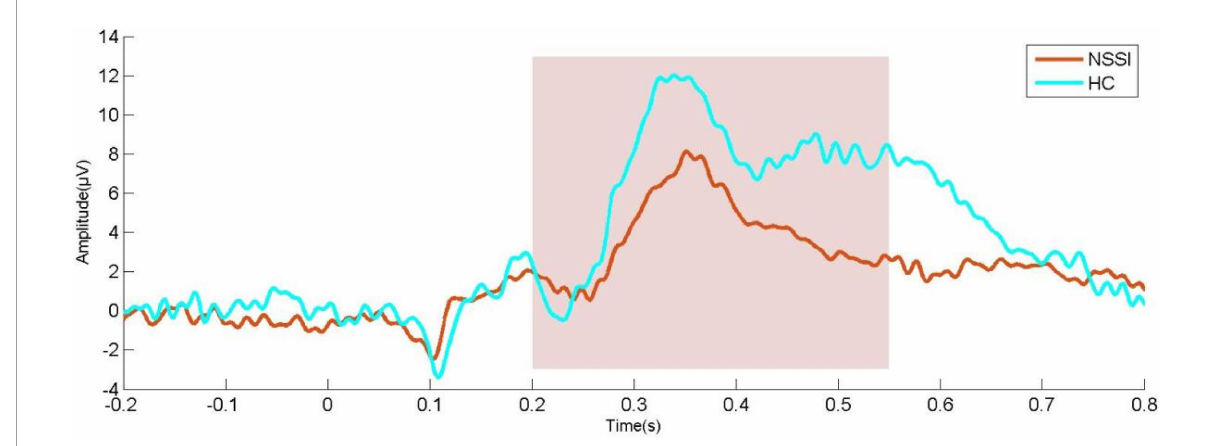
FIGURE1 Waveform diagram of P300 in CZ channel; NSSI, non-suicidal self-injury ( n = 62); HC, healthy control ( n = 44).